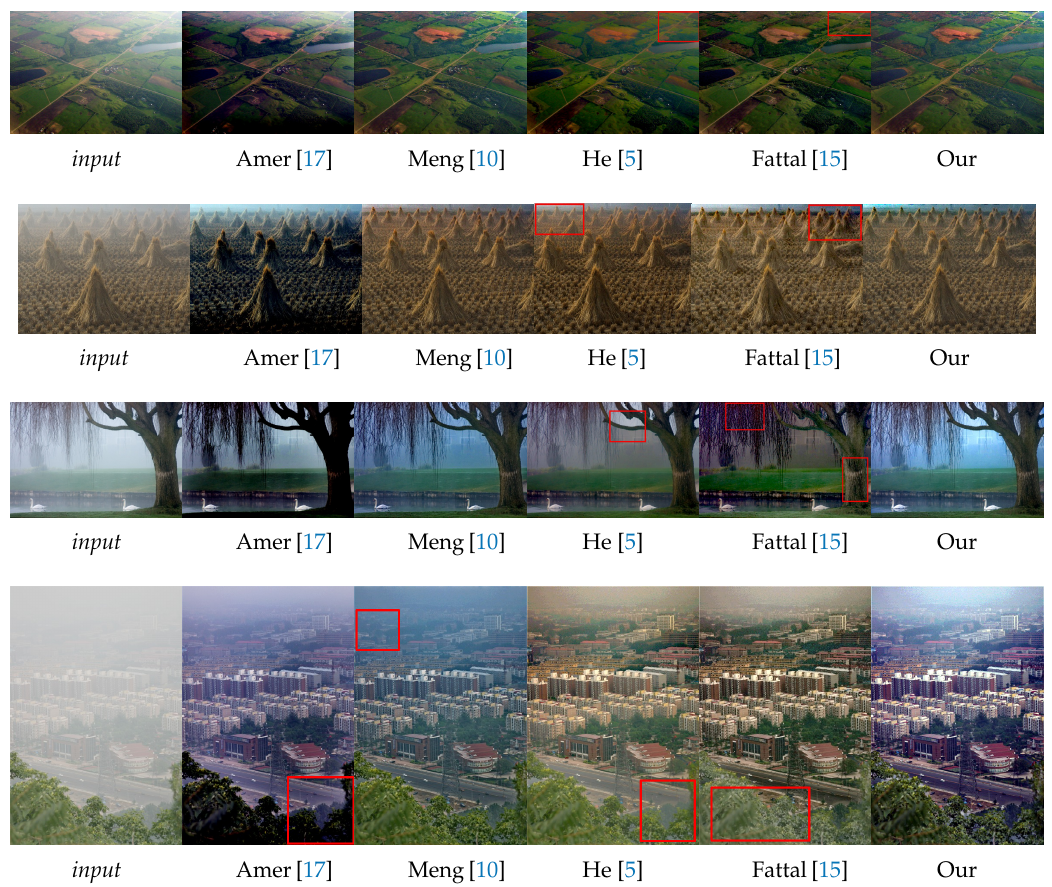
Figure 9. Qualitative results on well known images of the dehazing literature. Note that these images have a large variation of depth. Red boxes indicate dehazing